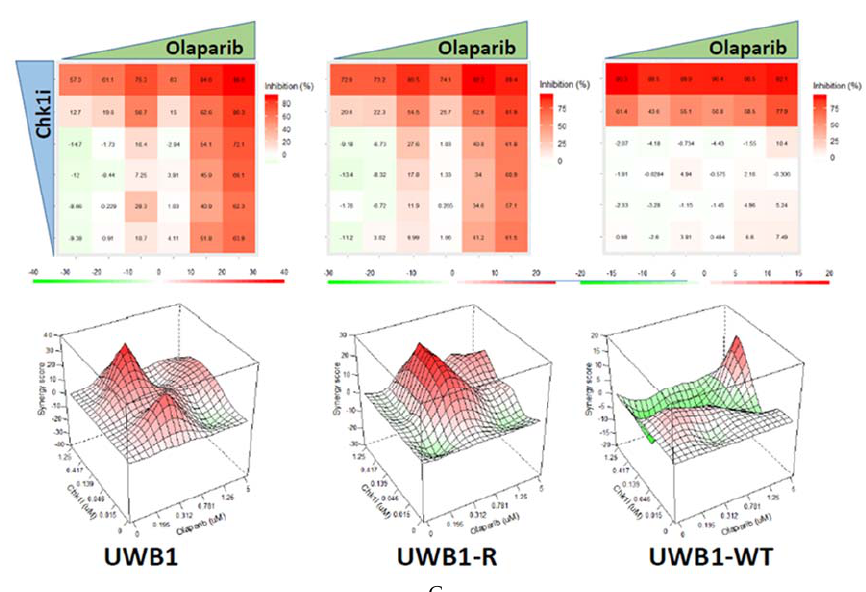
Figure 3. ( A ) Overall estimated Bliss scores for UWB1, UWB1 ‐ R and UWB ‐ WT cells for each drug combination of olaparib with: ATRi (Olap + ATRi), Chk1i (Olap + Chk1i), Wee1i (Olap + Wee1i), RAD51i (Olap + RAD51i). Olap + ATRi resulted in an overall synergy response for all cell lines with UWB1 ‐ WT significantly less than UWB1 and UWB1 ‐ R. Olap + Chk1i also resulted in an overall synergy response for UWB1 and UWB1 ‐ R cells, but antagonism for UWB1 ‐ WT cells. Olap + Wee1i and Olap + RAD51i combinations did not result in any significant synergy for the UWB1 and UWB1 ‐ R cells, but synergy was observed for the UWB1 ‐ WT cells. α < 0.05 = *, α < 0.01 = **, α < 0.001 = ***. Experiments were completed in duplicate with standard deviation error bars shown. ( B ) 2 ‐ D surface response for cell inhibition and 3 ‐ D surface Bliss synergy response for Olap + ATRi for UWB1, UWB1 ‐ R and UWB ‐ WT cells. ( C ) 2 ‐ D surface response for cell inhibition and 3 ‐ D surface Bliss synergy response for Olap + Chk1i for UWB1, UWB1 ‐ R and UWB ‐ WT cells.